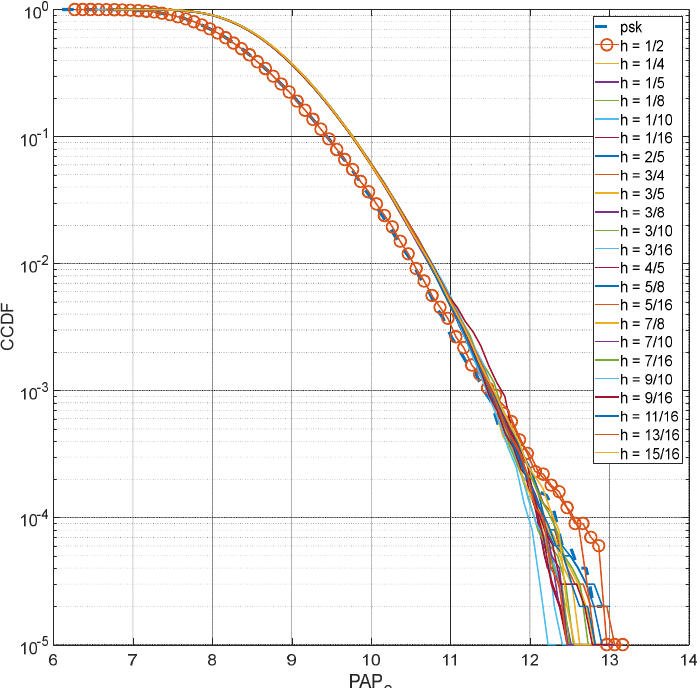
Figure 10. PAPR performance of CPM-OFDM as a function of 23 values of h with N = 512 and transmitter-receiver distance 500